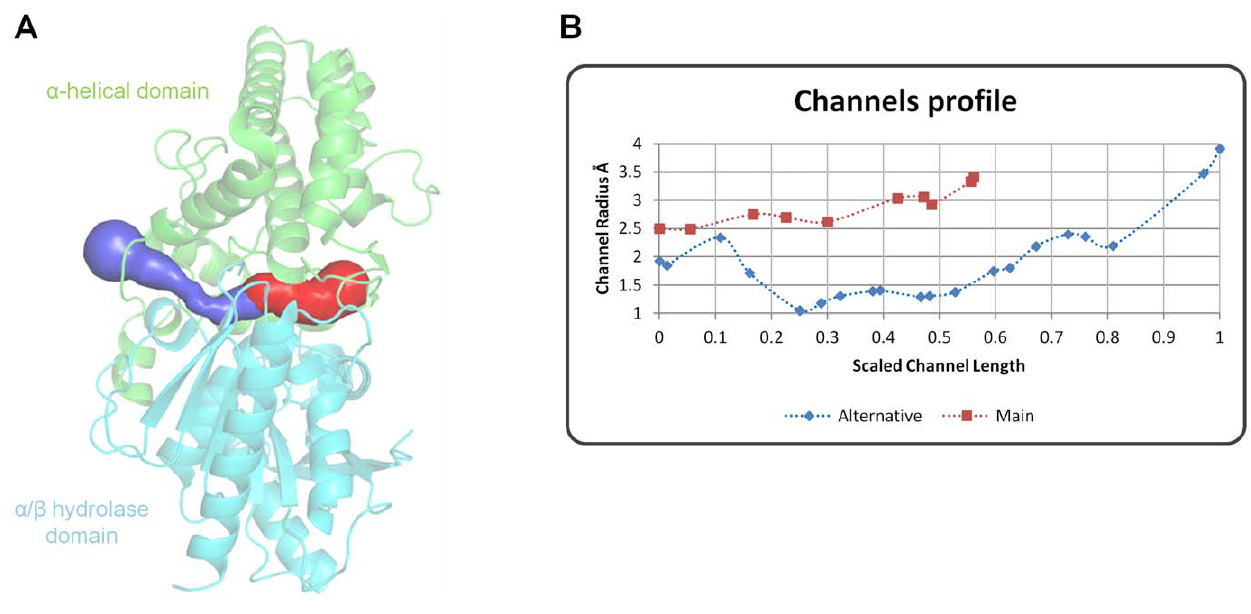
Figure 5. The channel system in DPP7. ( A ) The main channel is represented in red, and should be the route for the substrates to access the active site. It can be also visualized in Figure 1D. The products should be released either through the main channel or by an alternative channel (blue), identified by the Caver algorithm [39]. ( B ) Channels profile indicating the radius in A˚ vs. the scaled length, starting from the inhibitor position towards the protein surface. The figure was prepared using the program PyMOL (http://www.pymol.org/).